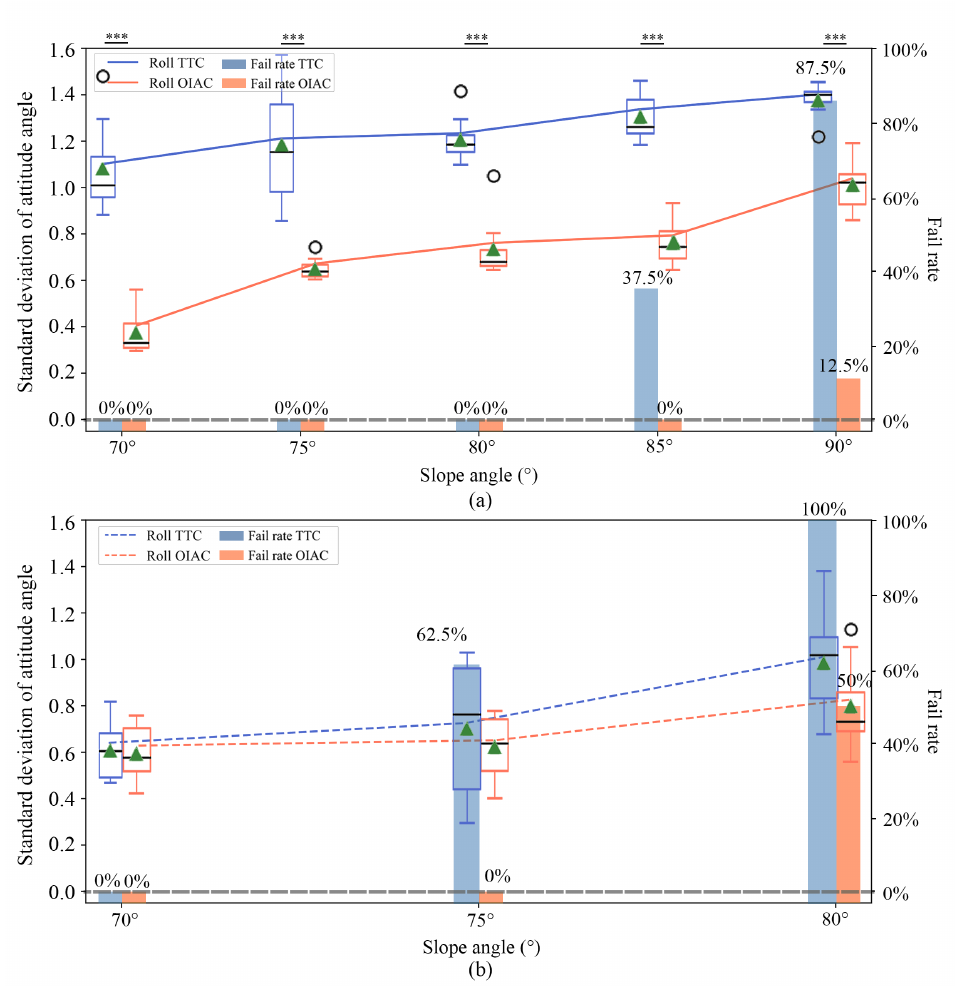
Figure 7. Statistical results of robot rolling angle α and the fail rate for various surfaces with various slope angles. Statistical results for ( a ) glass and ( b ) Teflon surfaces. In the box chart, the black lines represent the median position and the green triangles represent the average position. In the statistics, *** indicates a significant difference. The P value between roll under TTC and roll under OIAC on glass is 3.43 × 10 − 5 for 70°, 4.26 × 10 − 4 for 75°, 1.1 × 10 − 5 for 80°, 6.84 × 10 − 7 for 85°, and 2.82 × 10 − 5 for